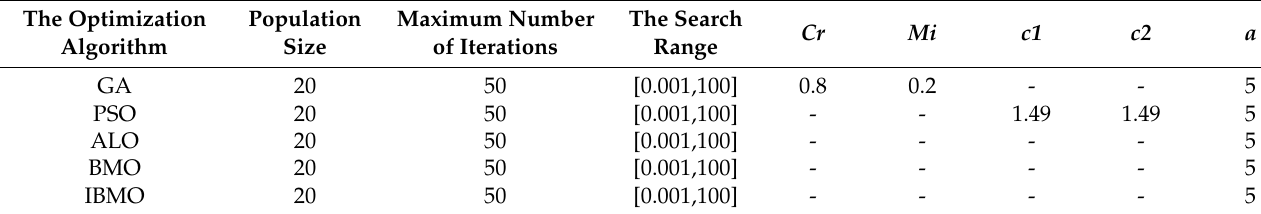
Table 4. Parameters of the algorithms.